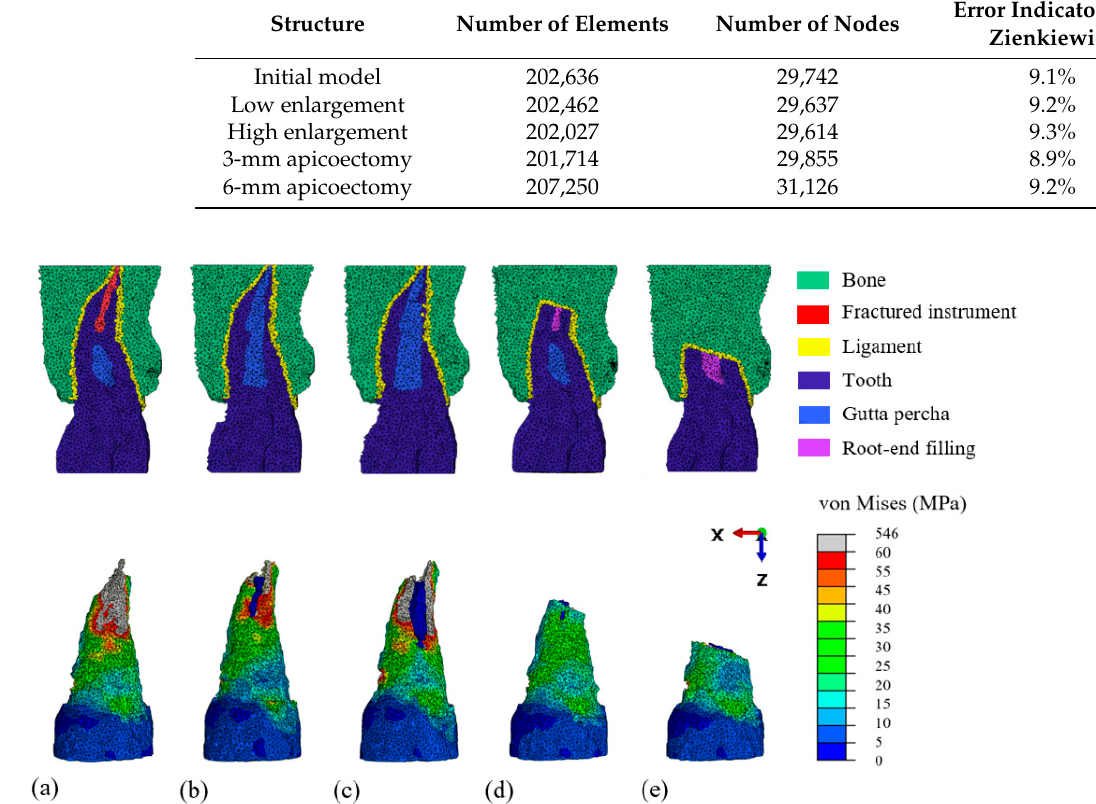
Figure 3. Cut views for each mesh and buccal views of Von Mises root stress represented by color, from blue (low values) to red (high values), for each finite element model. ( a ) Initial model representing the initial state, ( b ) low enlargement model, ( c ) high enlargement model, ( d ) 3 mm apicoectomy model, and ( e ) 6 mm apicoectomy model. Table 3. Patient-specific analysis based on the 3D image and maximal Von Mises stress of the dif- ferent removal strategies.